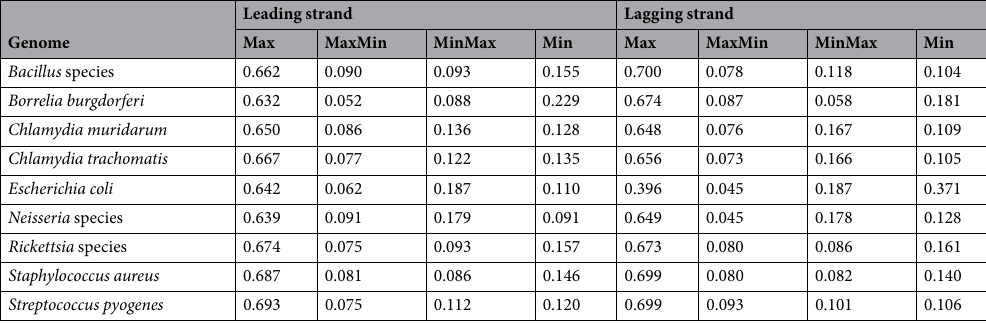
Table 1. Relative minimal distances of empirical matrices from two DNA strands in bacterial genomes to respective Pareto fronts of matrices maximizing hydropathy and minimizing polarity (MaxMin); minimizing hydropathy and maximizing polarity (MinMax); maximizing (Max) and minimizing (Min) the both costs. The distances were calculated in the final 2000th step of